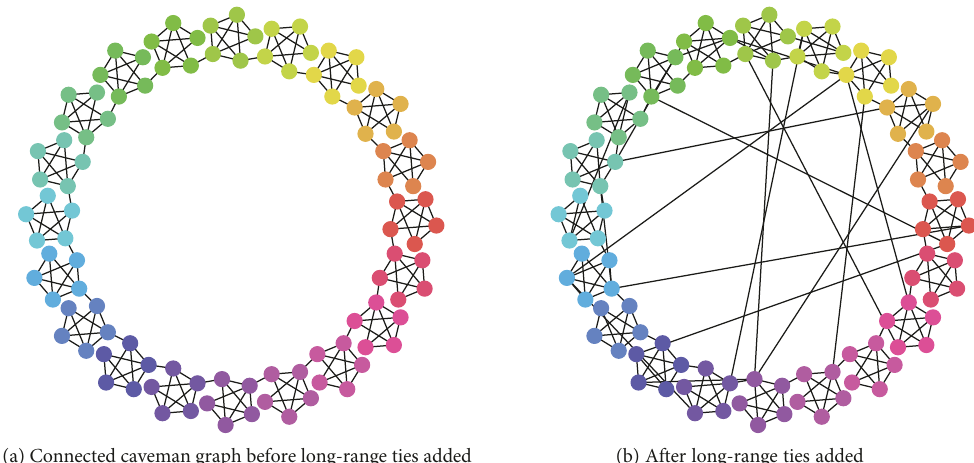
Figure 2: Connected caveman network with and without twenty long-range ties. Colors represent cave membership.